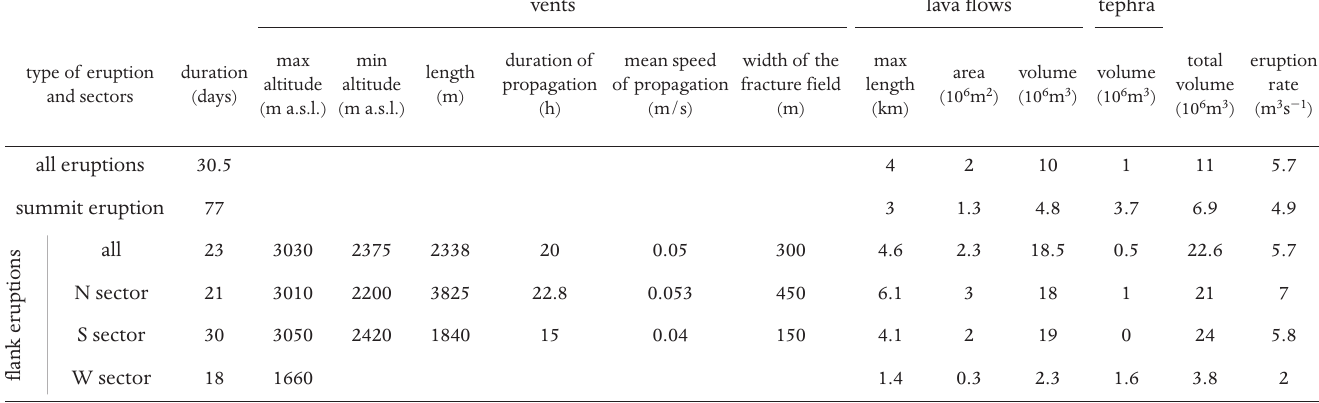
Table 2. Median volcanological and structural parameters of Etna eruptions, displayed for all of the post-1900 eruptions, summit and flank eruptions, and for each of the N, S and W